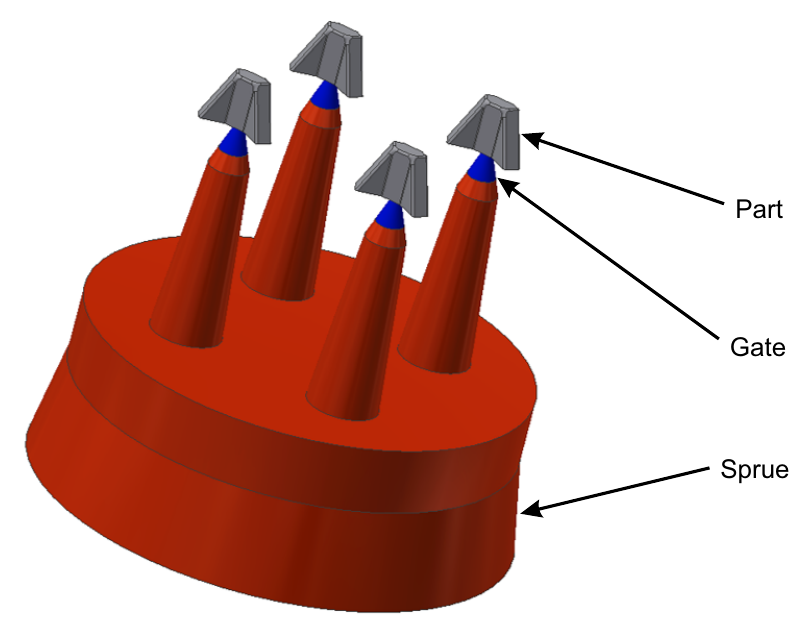
Figure 2. Schematic drawing of the runner system supplying four cavities, here abstract